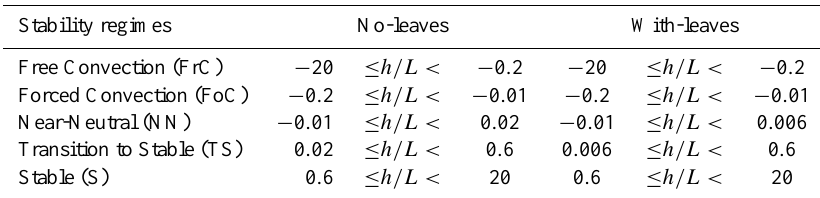
Table 1. Perimeters defining the five stability regimes, where L is the Obukhov length evaluated at the mean canopy height h . See Dupont and Patton (2012) for further